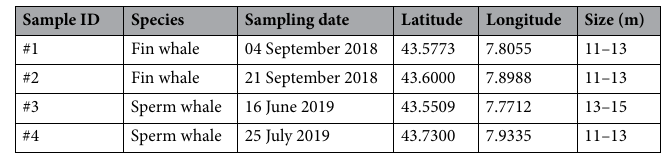
Table 1. Sample ID, sampling date, GPS coordinates and size of the investigated fin and sperm